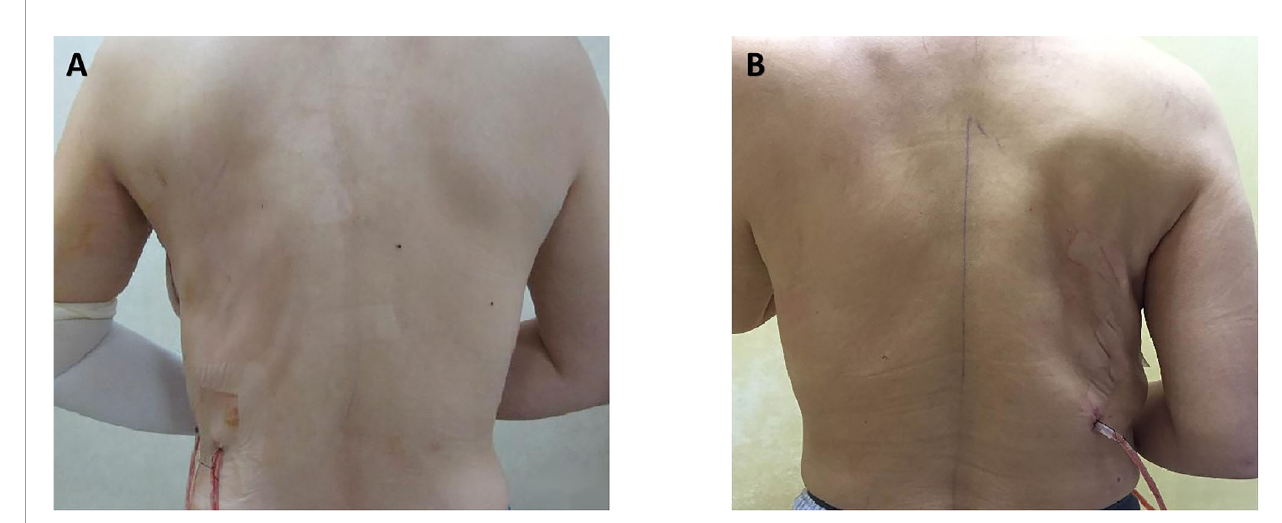
FIGURE 2 | Comparison of the back shapes after breast reconstruction at 1 week. The back photograph of a patient who underwent partial mastectomy with mini latissimus dorsi fl ap breast reconstruction (A) . The back photograph of a patient who underwent mastectomy with latissimus dorsi fl ap breast reconstruction (B) .